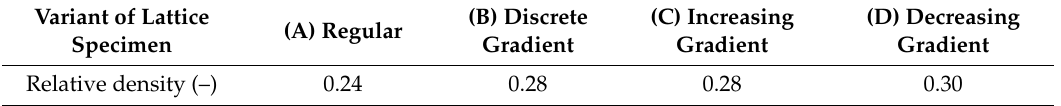
Figure 2. The detailed views of geometrical properties of a standard and a gradually changed lattice structure topologies. Table 1. Main features of designed variants of lattice specimens.